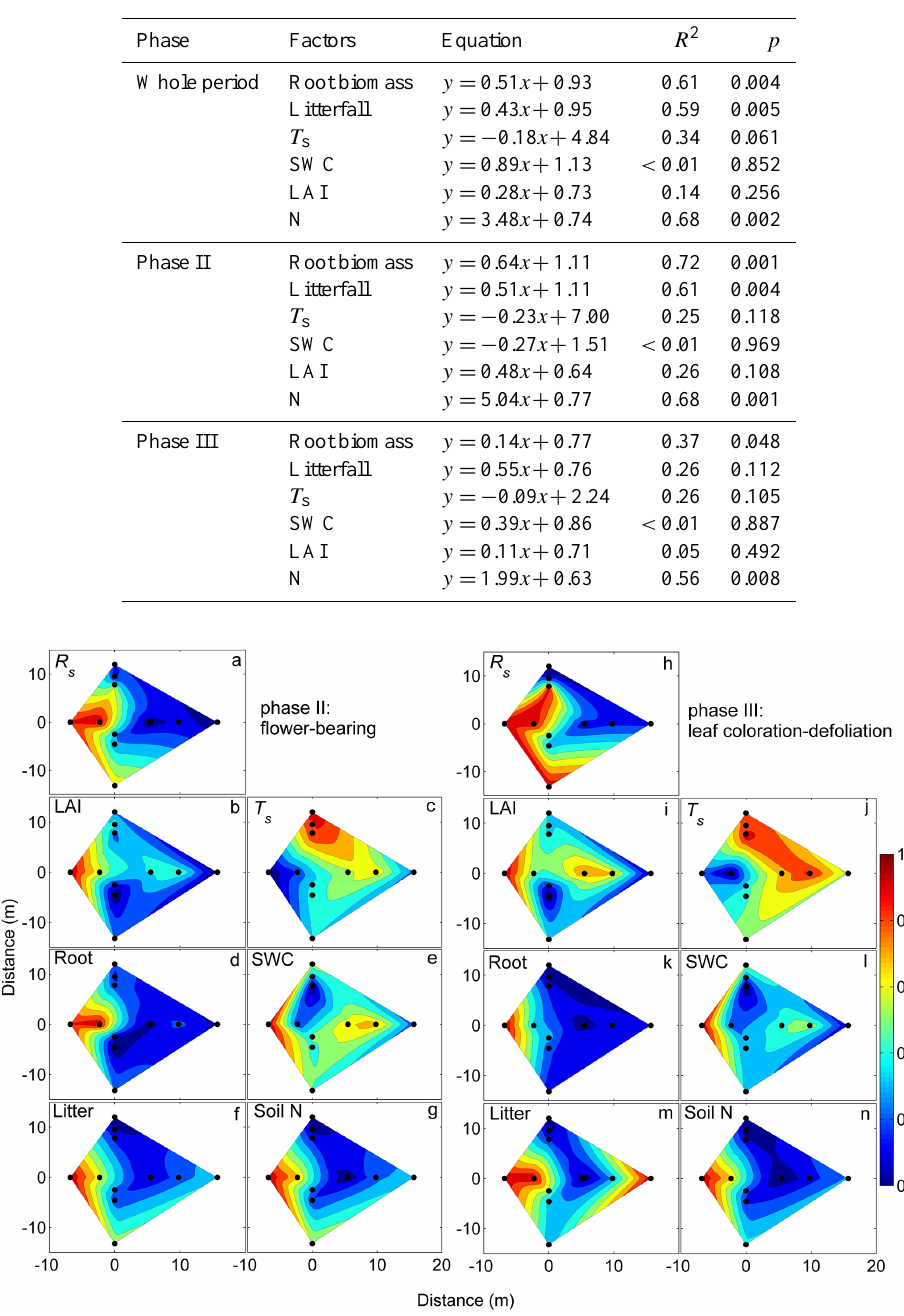
Table 3. Regression equations between R s ( y ) and different microhydrometeorological and plant-related factors ( x ) for the measurement period and flower-bearing (phase II) and leaf coloration–defoliation phase (phase III). T s : soil temperature ( ◦ C); SWC: volumetric soil water content (m 3 m − 3 ); Litter: litterfall (kgm − 2 ); Root: root biomass (kgm − 3 ); LAI: leaf area index (m 2 m − 2 ); N: soil nitrogen content at 0–25cm soil depths (gkg − 1 ).